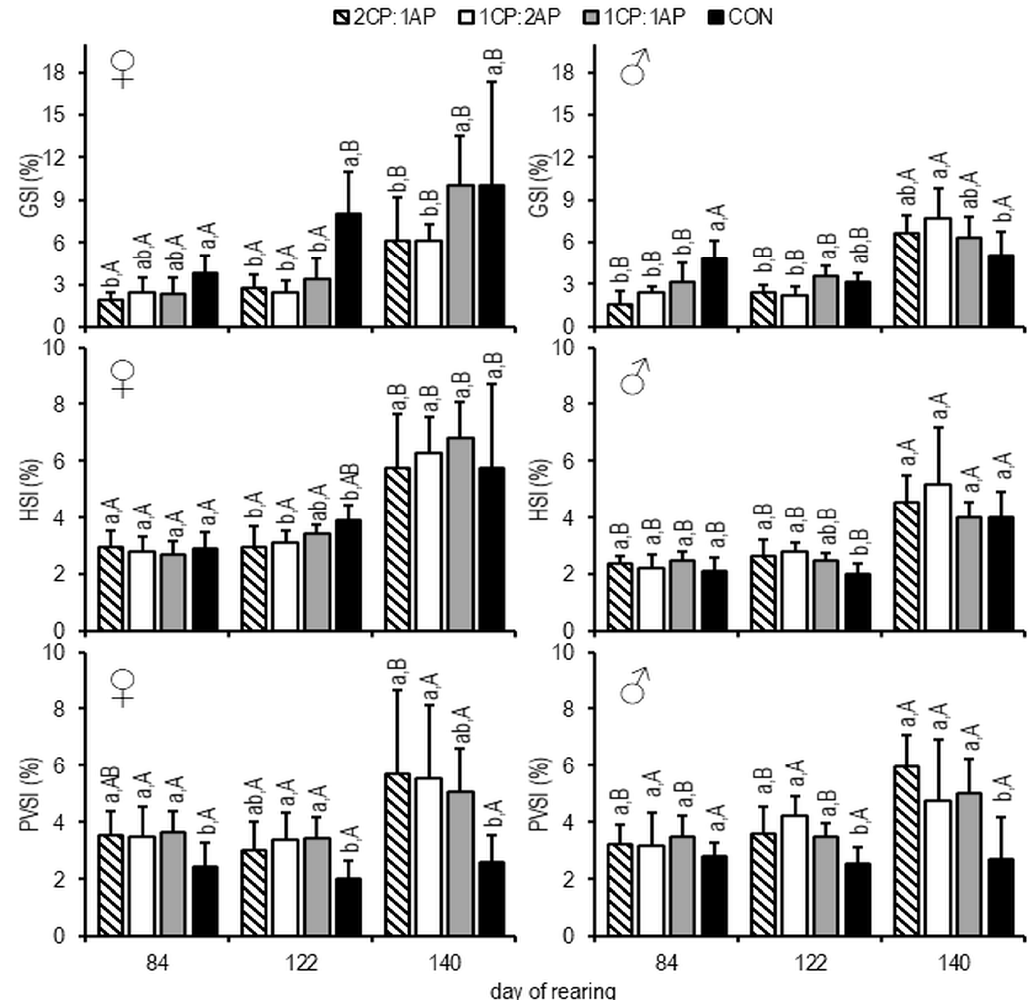
Figure 4. Hepatosomatic index (HSI, %), gonadosomatic index (GSI, %), and perivisceral fat index (PVSI, %) of brook trout reared under three non-circadian photoperiods (see Figure 1 for details). Data are mean (bars) ± SD—standard deviation (whiskers). Different small letters above bars indicate significant difference among treatments at a sample date ( p < 0.05) and different big letters indicate significant difference within the experiment group at a different sampling date ( p < 0.05). 2CP:1AP—group exposed to 24 h of ambient photoperiod alternating with a 48 h of continuous light, 1CP:2AP—group exposed to 48 h of ambient photoperiod alternating with a 24 h of continuous light, 1CP:1AP—group exposed to 24 h of ambient photoperiod alternating with 24 h of continuous light, CON—group exposed to natural ambient photoperiod as a